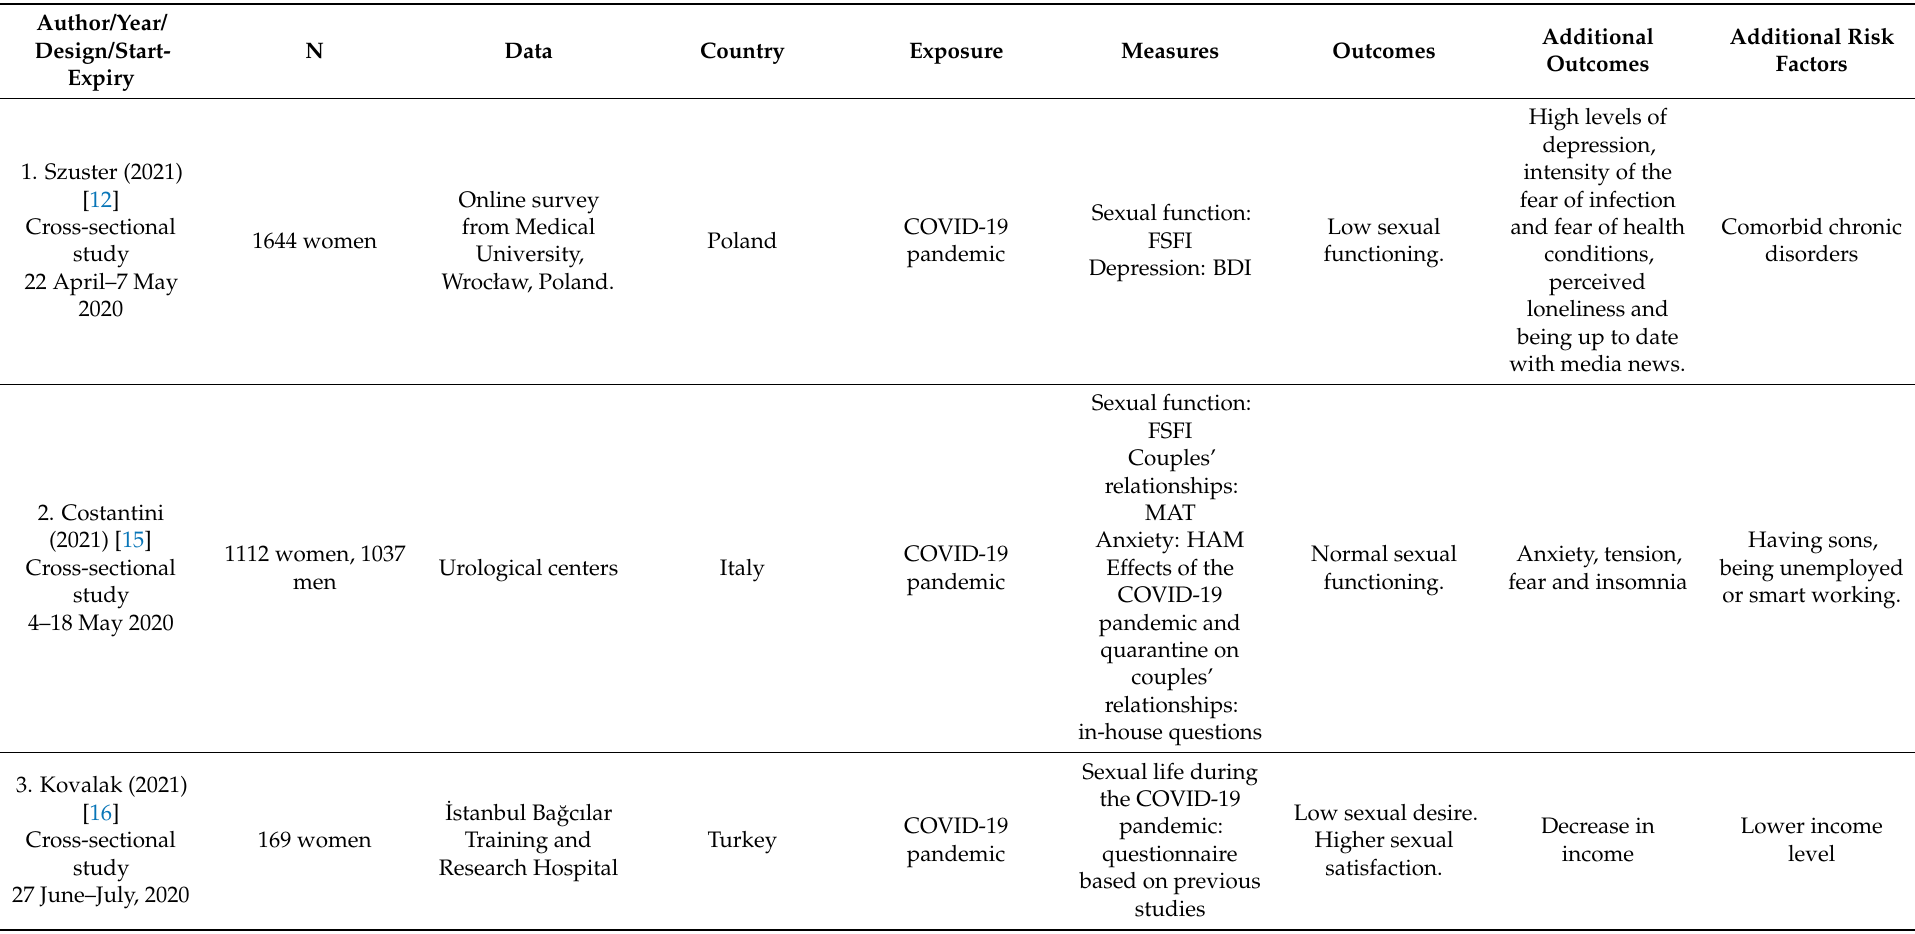
Table 3. Studies included in the systematic